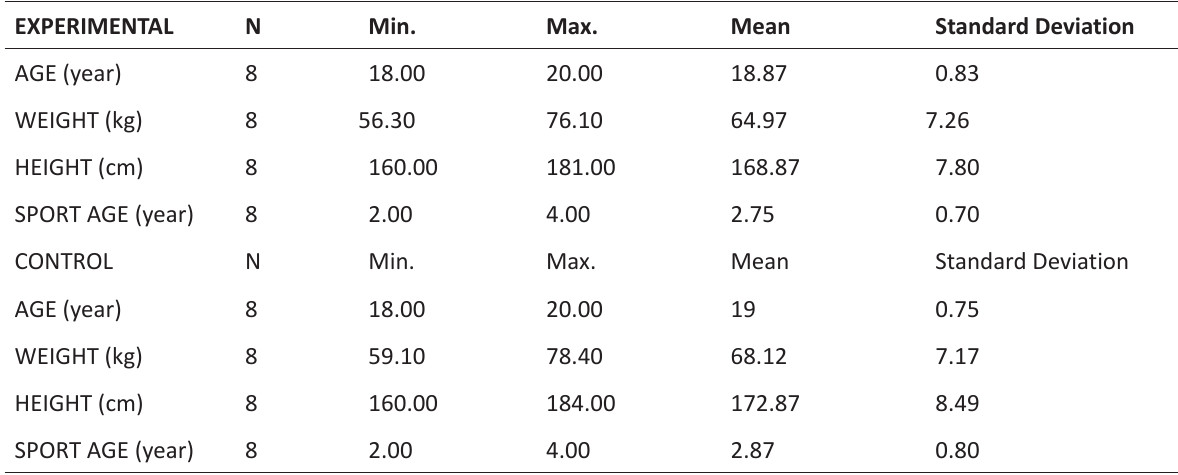
Table 2 . Anthropometric descriptive statistics of experimental and control group athletes EXPERIMENTAL